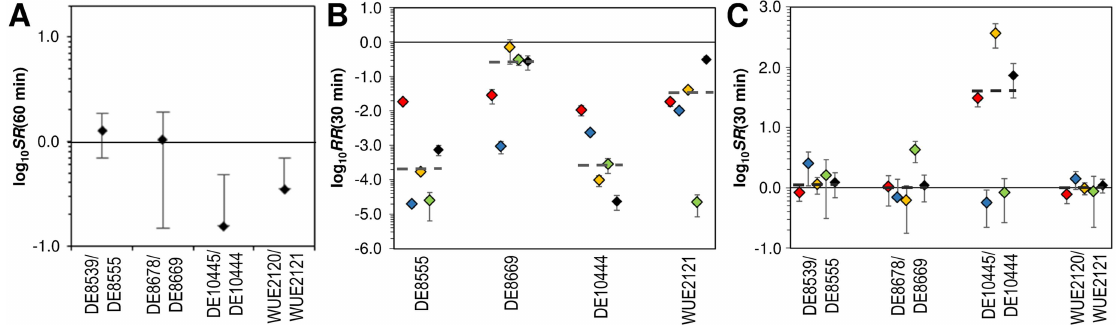
Fig 4. Comparison of the ex vivo fitness of meningococcal strains. (A) Comparison of the ex vivo selectionrates ( SR ) of blood relative to the corresponding throat isolates after 60 min incubationin 10% pooledhuman serum. Mean and standard deviationare depicted,and each experiment was carried out in triplicate. (B) Relativerecovery ( RR ) of throat isolates in human blood calculatedfrom the colony forming units ( CFU ) at 0 min and 30 min accordingto RR (30 min) = CFU (30 min)/ CFU (0 min) (13). (C) Comparisonof ex vivo selectionrates ( SR ) of blood relative to the correspondingthroat isolates in humanblood calculatedas SR (30 min) = RR blood isolate (30 min)/ RR throat isolate (30 min) (13). For each strain (pair) and donor, the scatter plot gives the mean and standarddeviationof three independentexperiments. Each donor is color-coded. For each strain (pair), dashed lines indicate the medianRR and SR values, respectively, over all five